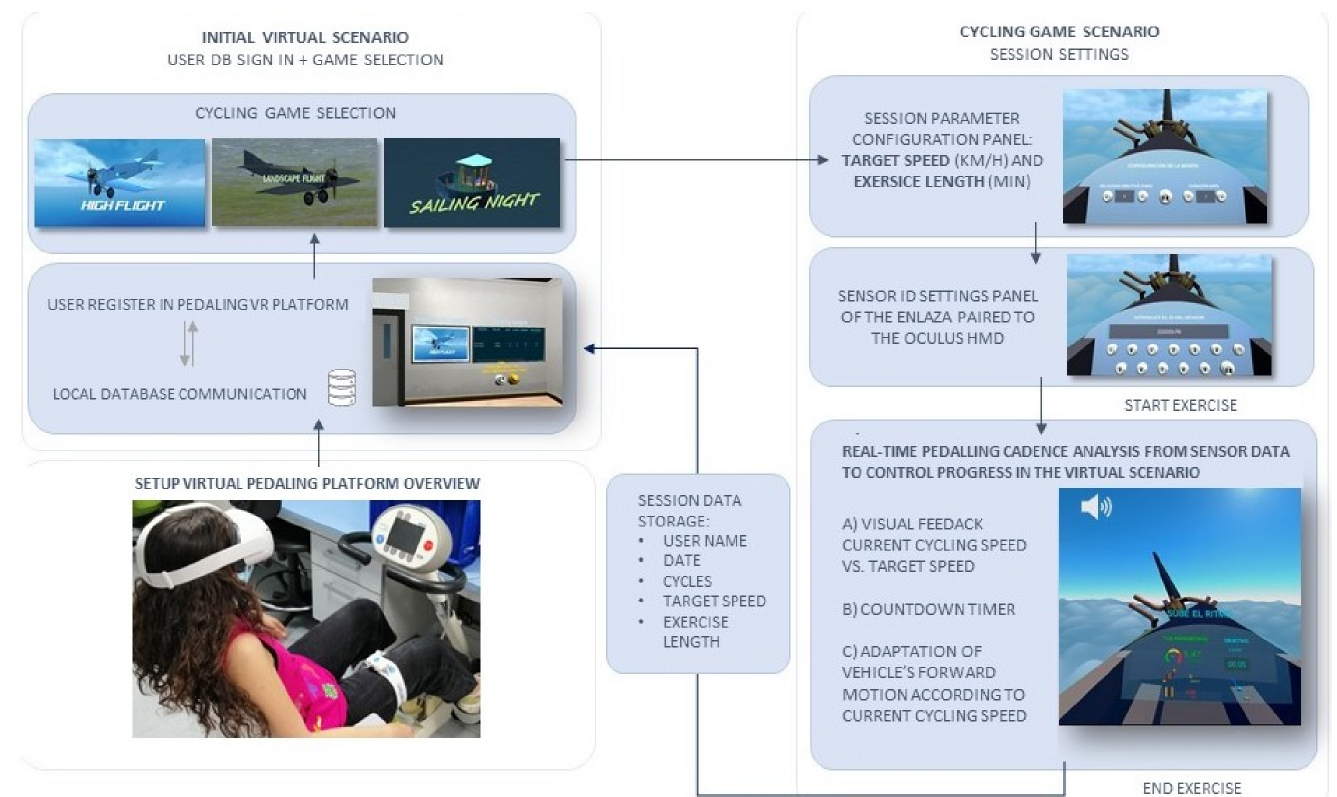
Fig 3. Workflow diagram of the Pedaling Virtual Platform user experience. MOTOmed scheme [28].